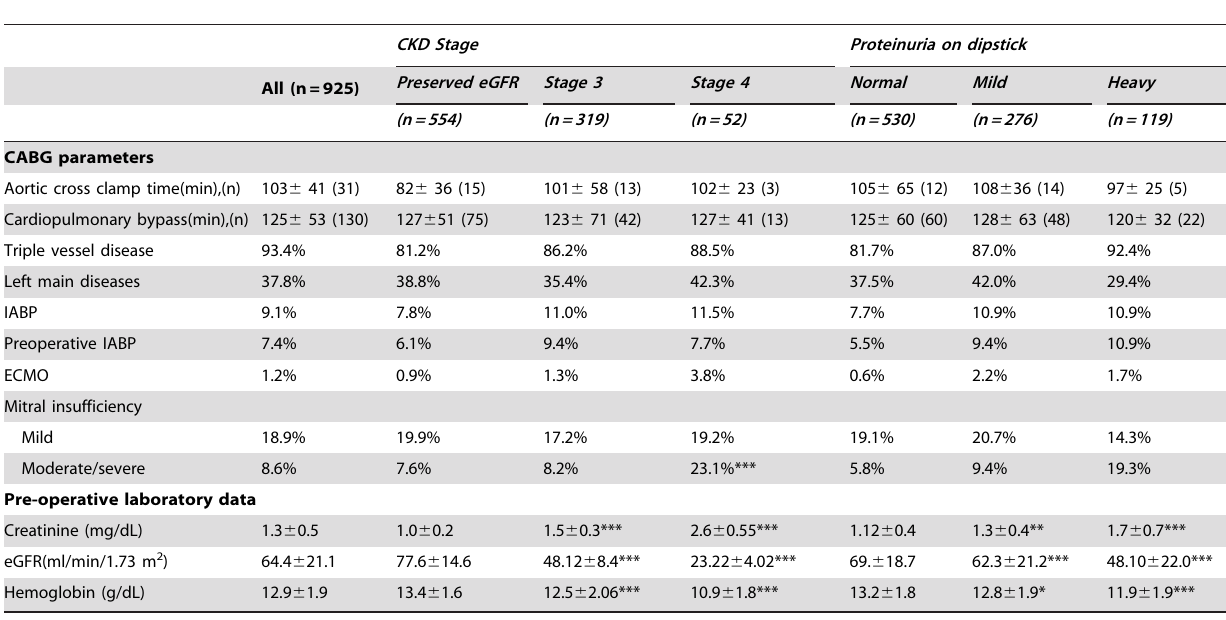
Table 2. Operative characteristics and renal function, classified by CKD stages or proteinuria.